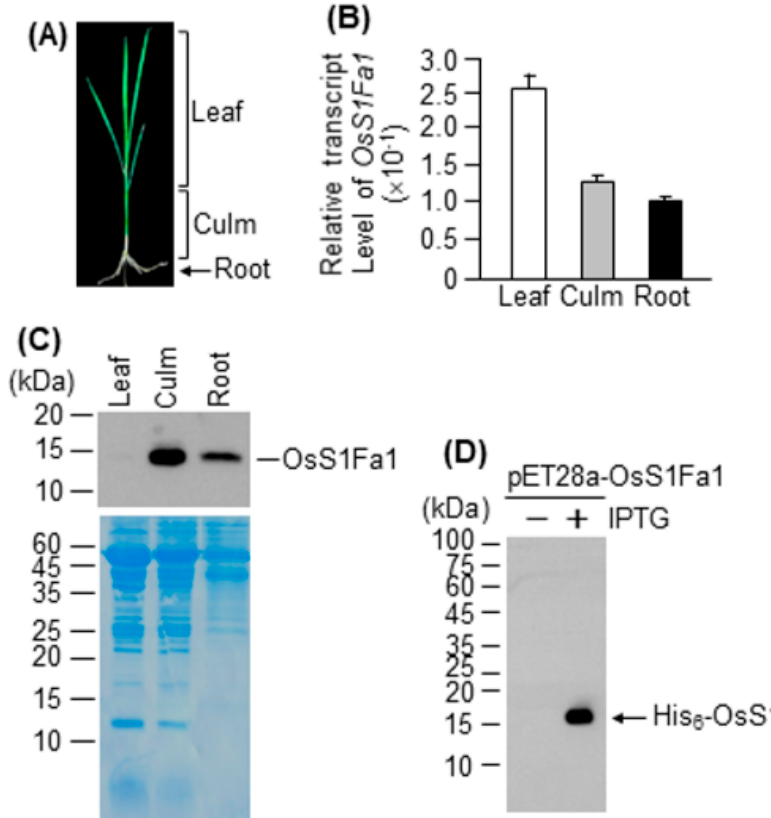
Figure 2. Analysis of OsS1Fa1 expression in rice tissues and detection of the His-tagged recombinant proteins in E. coli . ( A ) Photograph of a 3-week-old rice seedling showing the leaf, culm, and root tissues used for total RNA isolation. ( B ) Expression analysis of OsS1Fa1 in rice tissues by RT-qPCR. Data represent mean ± SD ( n = 3). ( C ) Western blot analysis of OsS1Fa1 in rice tissues using anti-OsS1Fa1 antibody. Total proteins were extracted from the same samples as those used in ( B ). The corresponding protein gel is shown below. ( D ) Detection of the His 6 -OsS1Fa1 recombinant protein in E. coli extracts using anti-OsS1Fa1 antibody. The recombinant protein was detected in E. coli before and after the addition of IPTG.